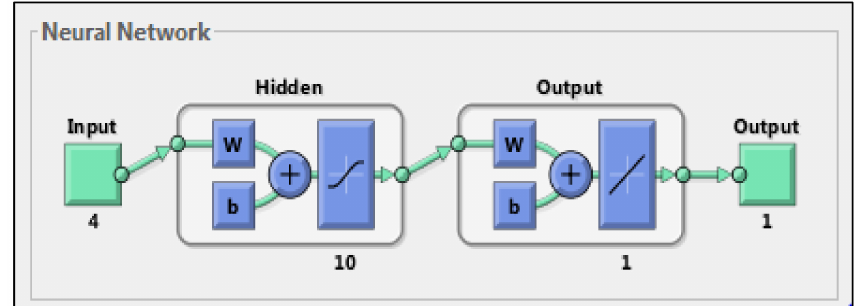
Figure 6. Artificial neural network (ANN) configuration applied on original data.